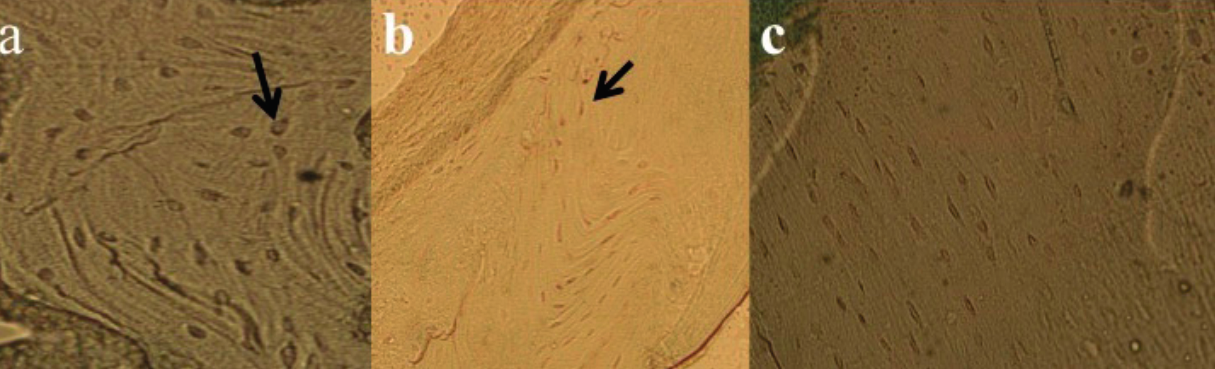
Figure 7. Tunnel assay, arrows point apoptotic cells ( a ) Group A; ( b ) Group B; ( c ) Group C (at